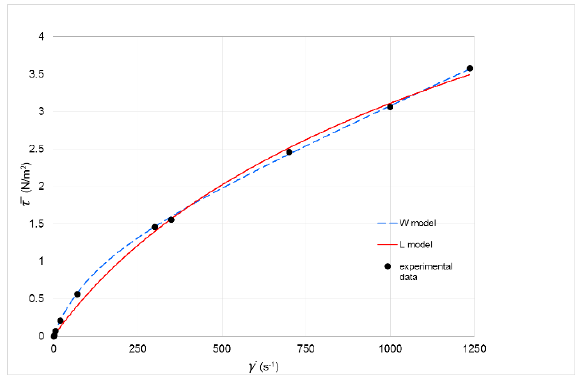
Figure 2. Microgel-free xanthan polysaccharide dissolved in a saltwater (salinity = 5 g / L NaCl, temperature = 30 °C); experimental data [11] fitted by W and L models.